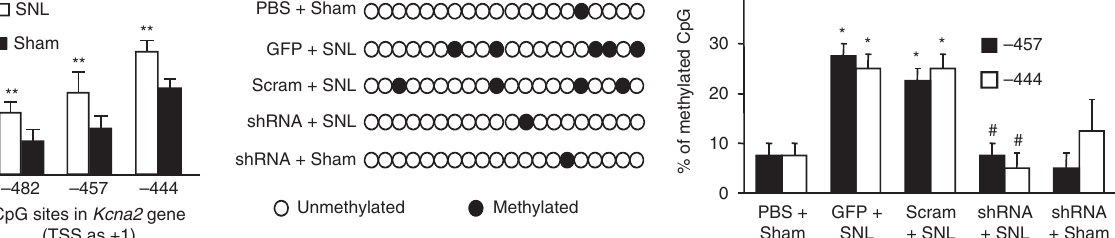
the Kcna2 gene promoter may interfere with the binding of